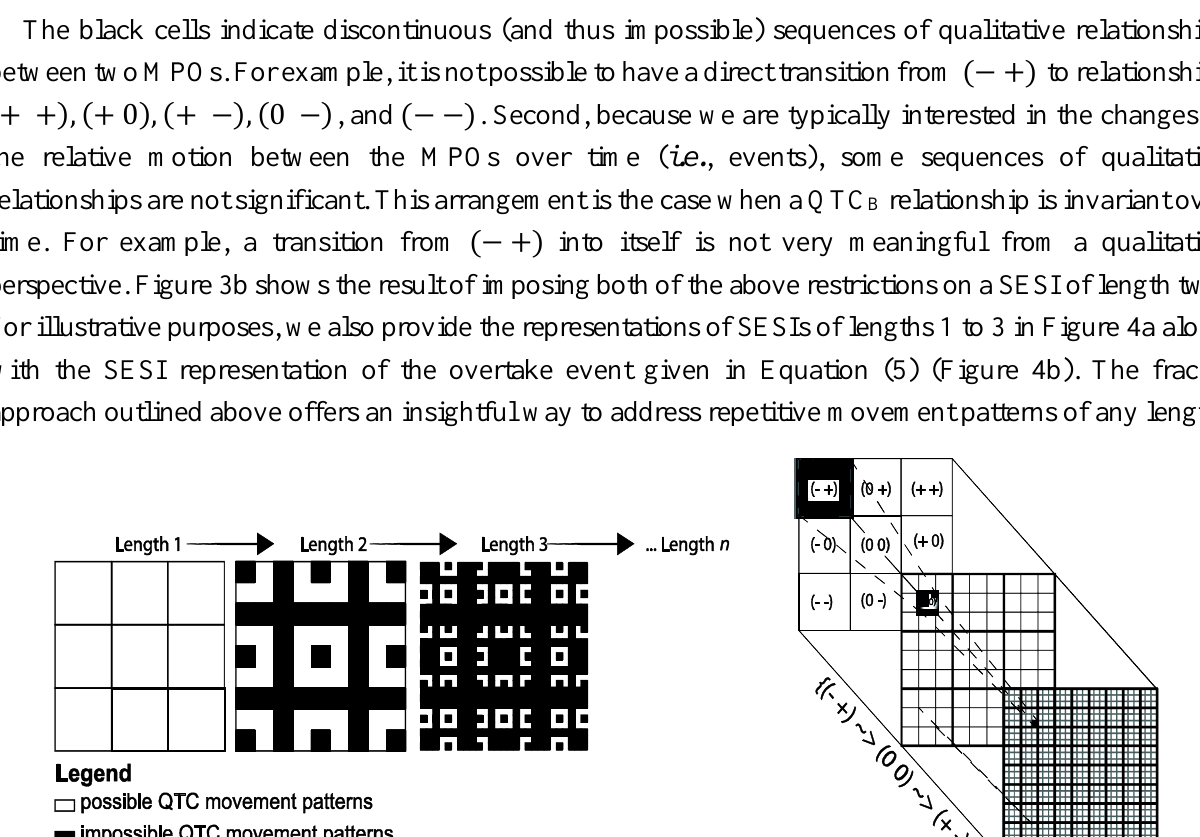
Figure 3. ( a ) Continuity and ( b ) event-based constraints imposed on a SESI of length